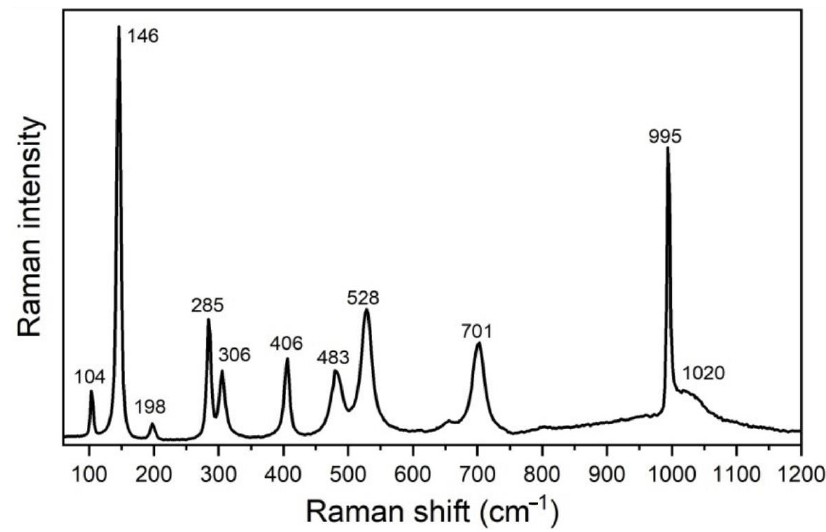
Figure 5. Experimental Raman spectrum of V 2 O 5 catalyst (after a baseline correction).